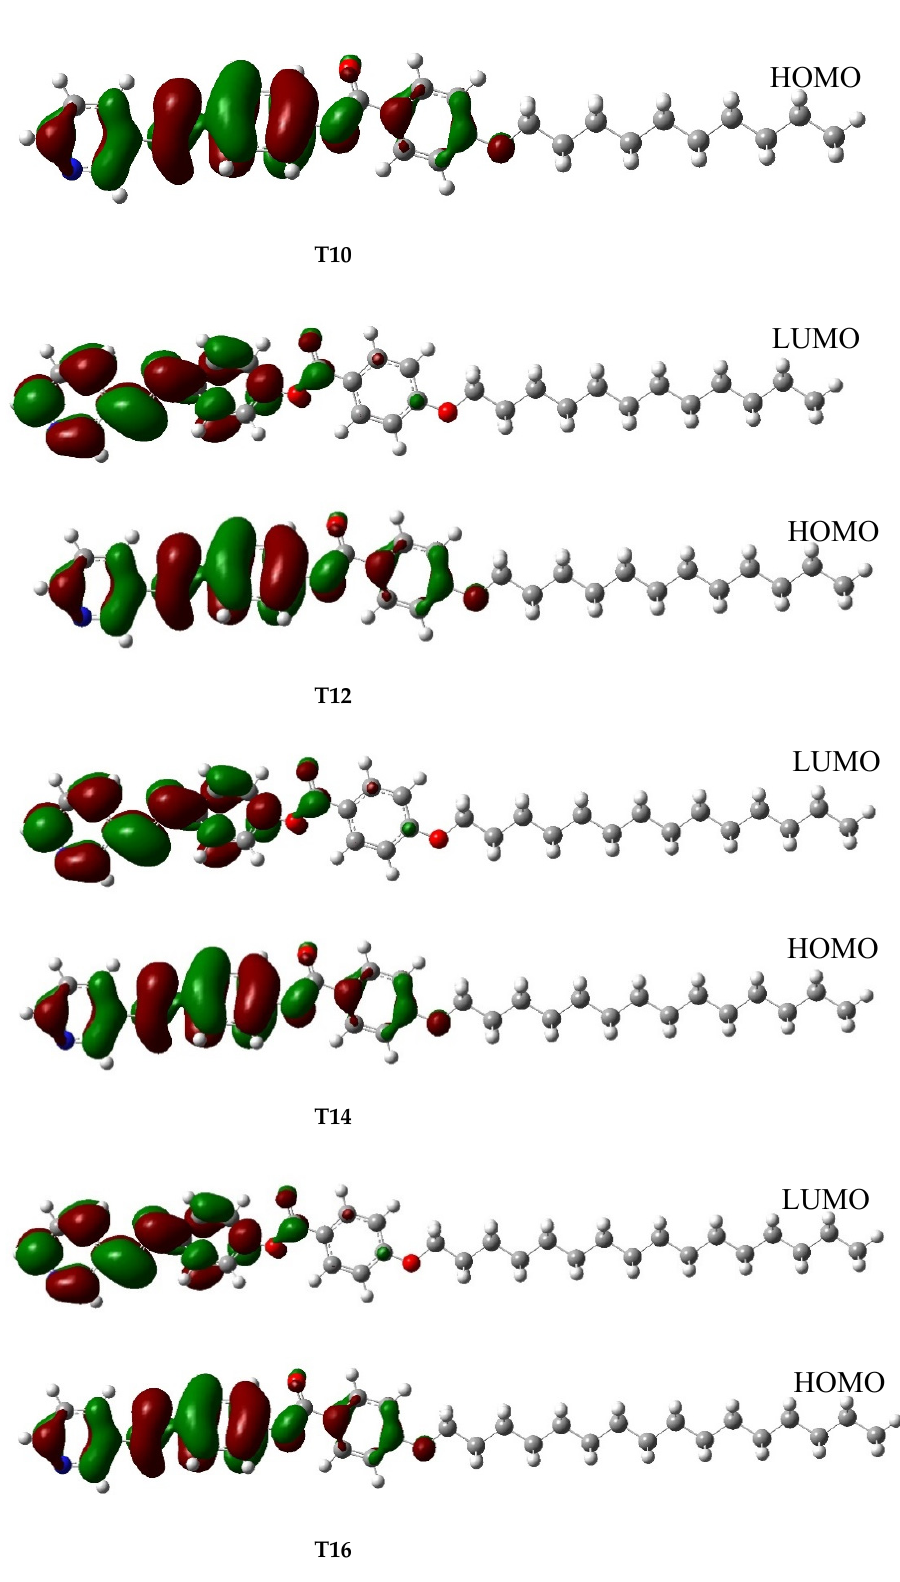
Figure 4. Frontier molecular orbitals for the compound Tn calculated at the B3LYP/6–31g(d,p) lev- el.